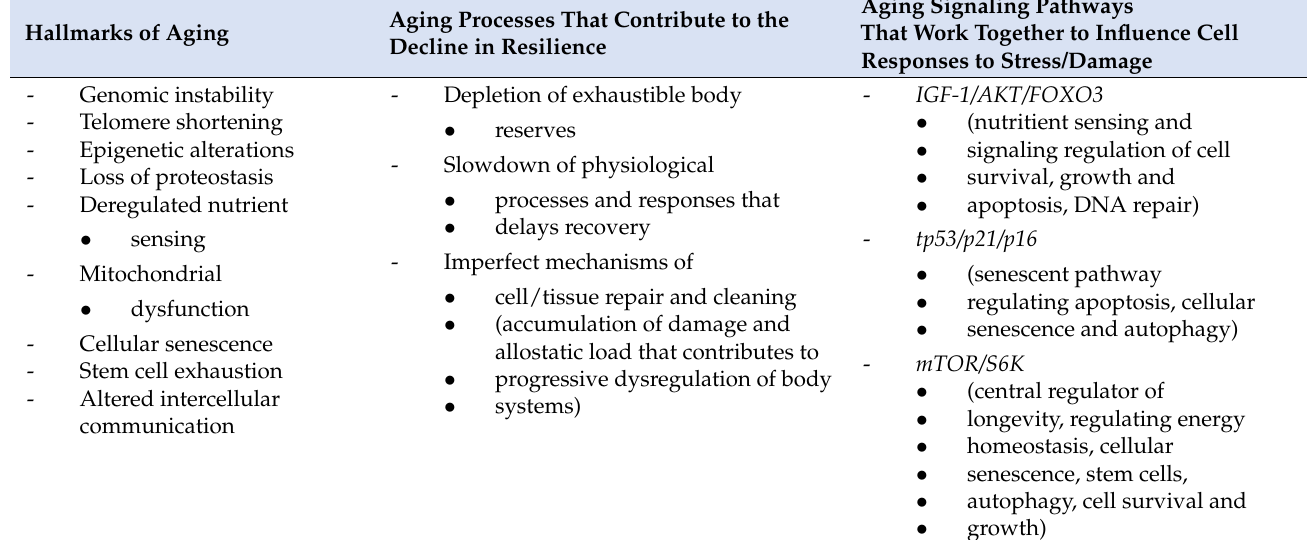
Aging Signaling Pathways That Work Together to Influence